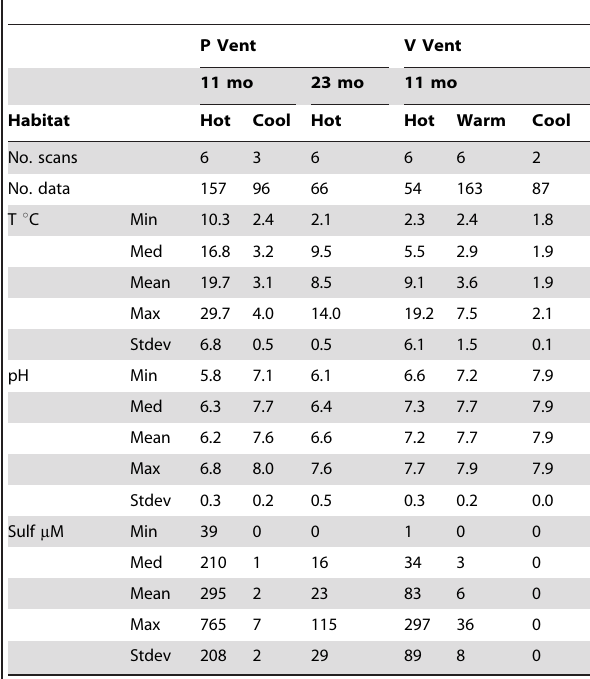
Table 2. Temperature (T u C) and chemical measurements (pH and free sulfide) analyzed by